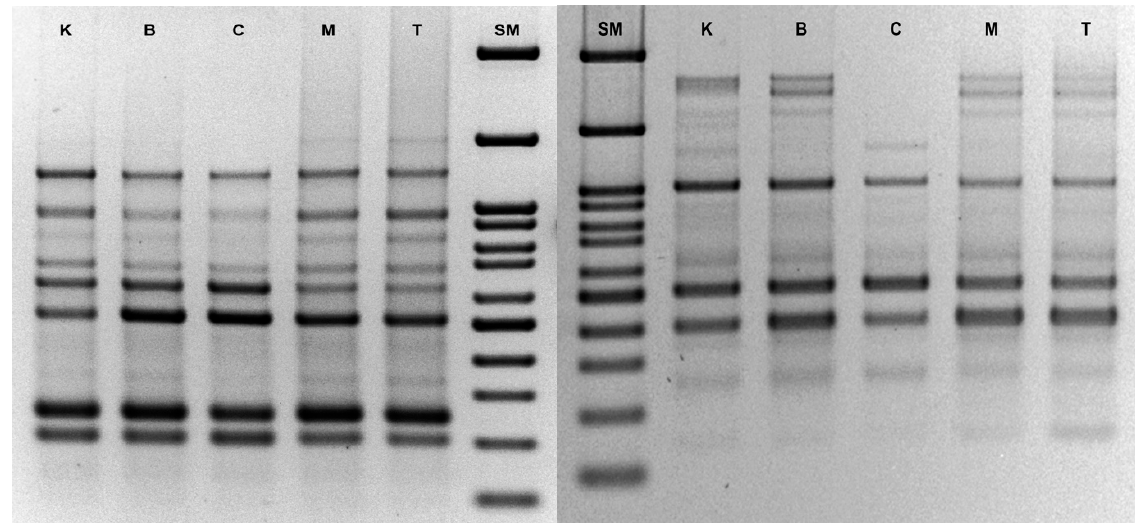
Figure 3. ISSR profile of control shoot culture and shoot lines obtained in the presence of different cytokinins of S. bulleyana (primer UBC 1—left, UBC 841—right; SM—Fast gene ruler 100 bp, K—control, B—BAP, C—CPPU, M—mT, T—TDZ).